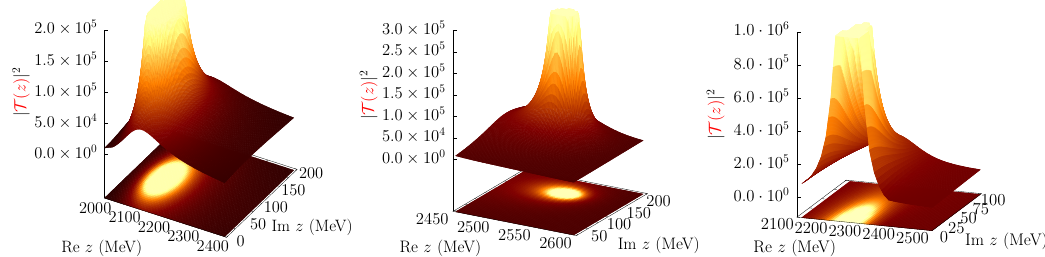
Figure 4: Generated poles at T = 0 in the heavy-light meson system. Left: Lower ( 2300 ) resonance. Middle: Higher pole of the D ∗ pole of the D ∗ 0 ( 2317 ) bound state. Figure taken from [ 4 ] . Right: Pole of the D ∗ s 0